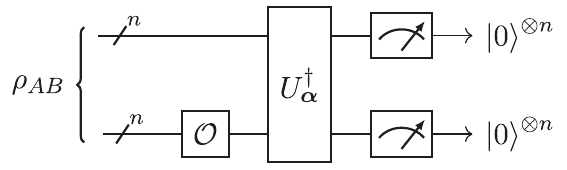
(cid:3) (cid:4) (cid:2) (cid:3) (cid:3) (cid:3) in Equation (7). O ð ρ AB Þ ψ